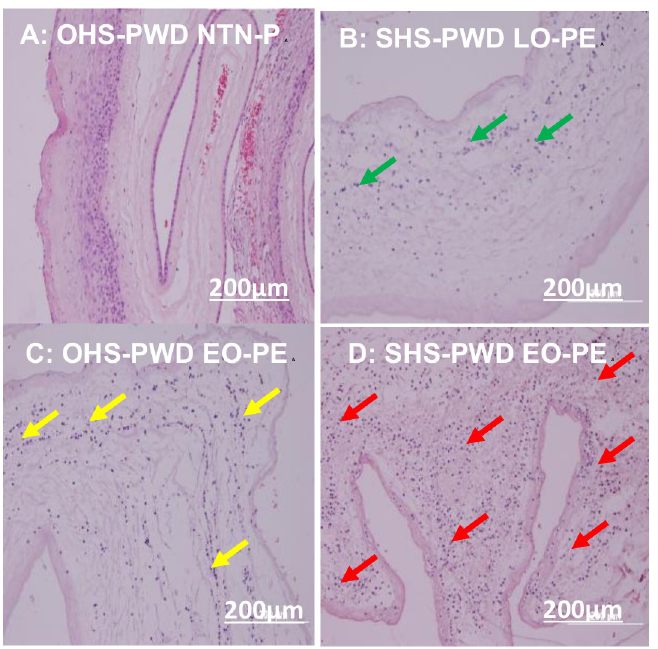
Fig 4. Photomicrographs of chorioamniotic membrane of SHS and OHS-PWD EO-PE and LO-PE compared to NTN-P. A: normal chorioamniotic membrane of OHS- pregnant women who experienced NTN-P at 38 weeks (magnification x20). B: mild acute inflammatory granulocytes infiltrates (chorioamnionitis) (green arrows) in SHS- pregnant women who developed LO-PE at 36 weeks (magnification x20). C: moderate acute inflammatory granulocytes infiltrate (chorioamnionitis) (yellow arrows) in OHS-PWD EO-PE at 33 weeks associated with PPROM (magnification x20). D: severe acute inflammation granulocytes infiltrate (chorioamnionitis) (red arrows) in SHS- pregnant women who developed EO-PE placenta at 32 weeks associated with preterm premature rupture of membrane (PPROM) (magnification x20). Scale bar = 200 μ m.